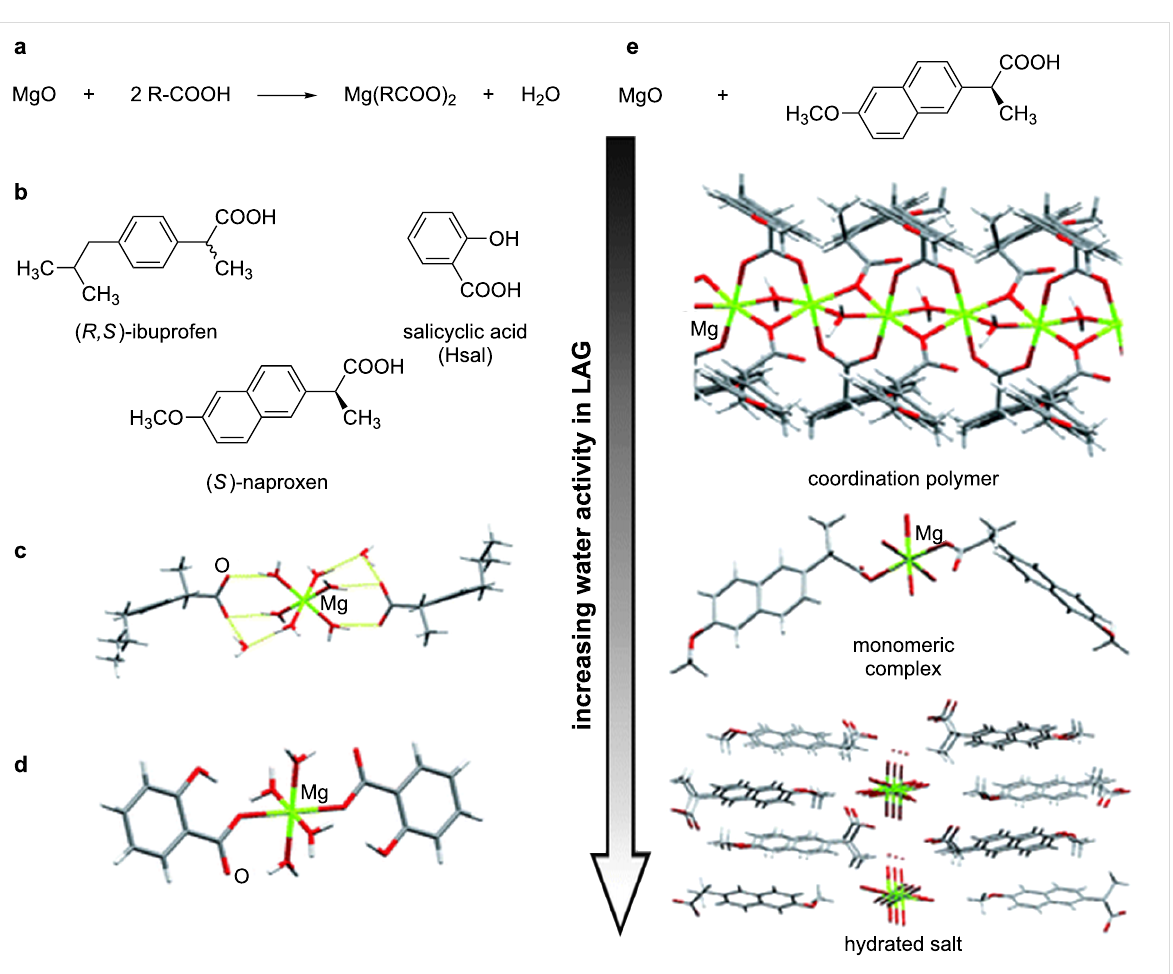
Figure 2: a) Mechanochemical reactivity between the excipient MgO and carboxylic acid NSAID molecules; b) NSAID molecules explored in mechanochemical reactions with MgO; c) fragment of the crystal structure of a mechanochemically obtained magnesium–ibuprofen complex; d) fragment of the crystal structure of a mechanochemically obtained magnesium–salicylate complex; e) screening for different hydrated forms of magnesium–naproxen BioMOFs by systematically varying the quantity of water in LAG reactions of MgO and ( S )-naproxen. Reprinted with permis- sion from [29], copyright 2012 the Royal Society of